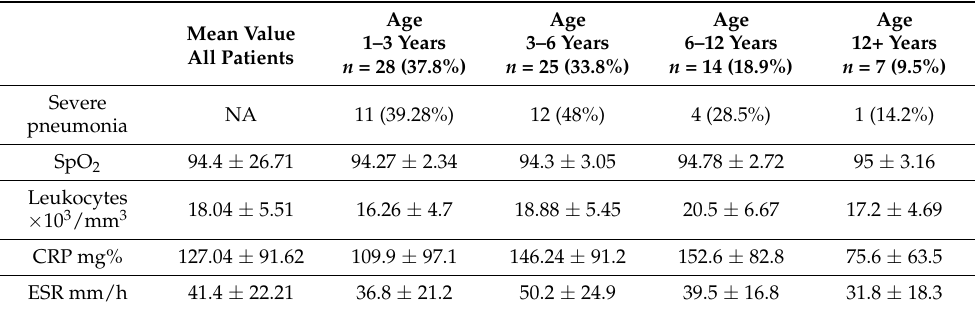
Severe pneumonia was diagnosed in 37.8% of admitted children (Table 2). Table 2. Percentages of severe pneumonia forms and mean values and SDs of patient’s SpO 2, leucocytes, CRP, and ESR, by age groups.